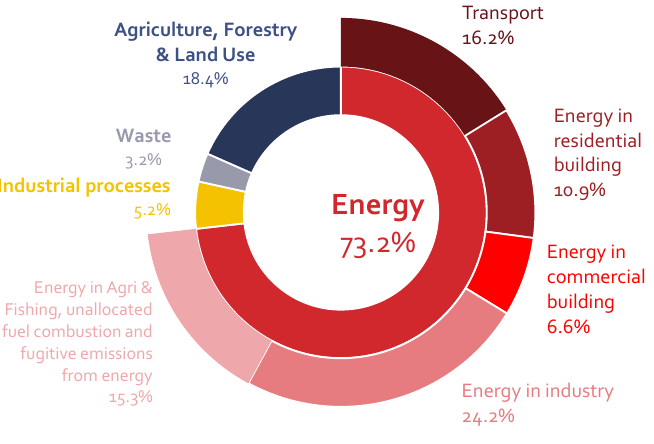
Figure 1. Sources of total CO 2 worldwide